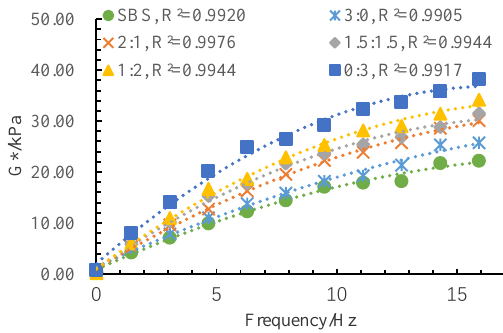
Figure 10. Test results of complex modulus .